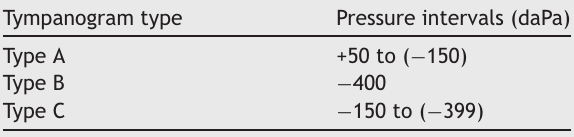
Tympanogram types (daPa).